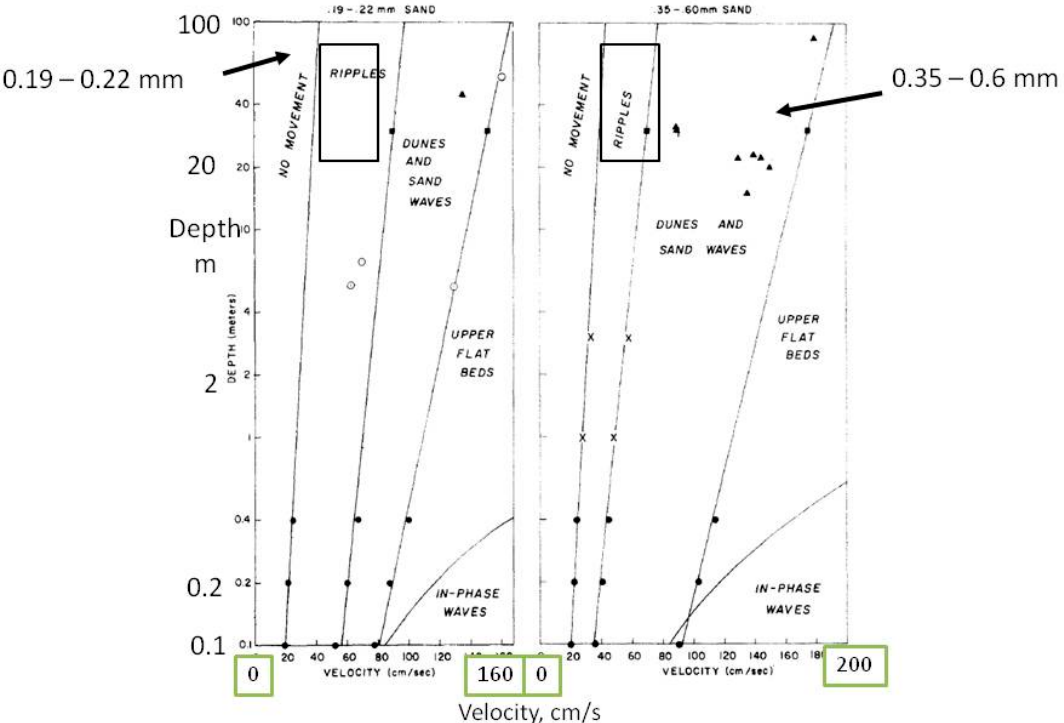
Figure 13. Bed-phase diagram for San Francisco Bay developed by Rubin and McCulloch [27] whose Figure 13. San Francisco Bay bed-phase observations were combined with those of Southard [25], observations were combined with those of Southard [25], Boothroyd and Hubbard [37], and Dalrymple Boothroyd and Hubbard [37], and Dalrymple and others [26], and a single set of bed-phase and others [26]. Black boxes are for data collected by this study in the San Juan boundaries was drawn from the combined data. Modfied after Rubin and McCullock [27].